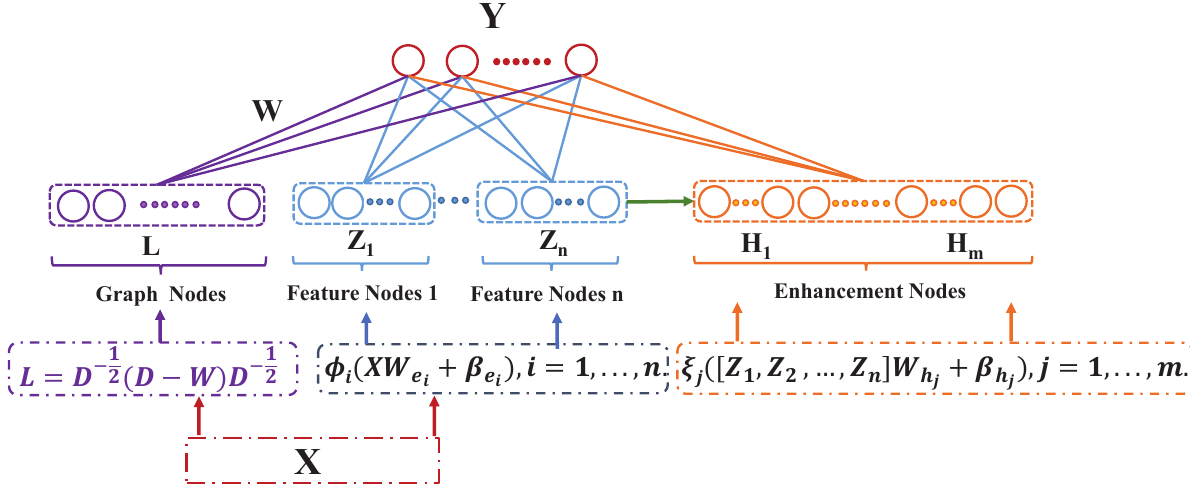
Figure 5. Illustration of the structure of graph-represented Broad Learning